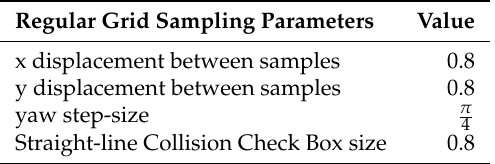
Table 2. Regular Grid Sampling Approach Parameters.